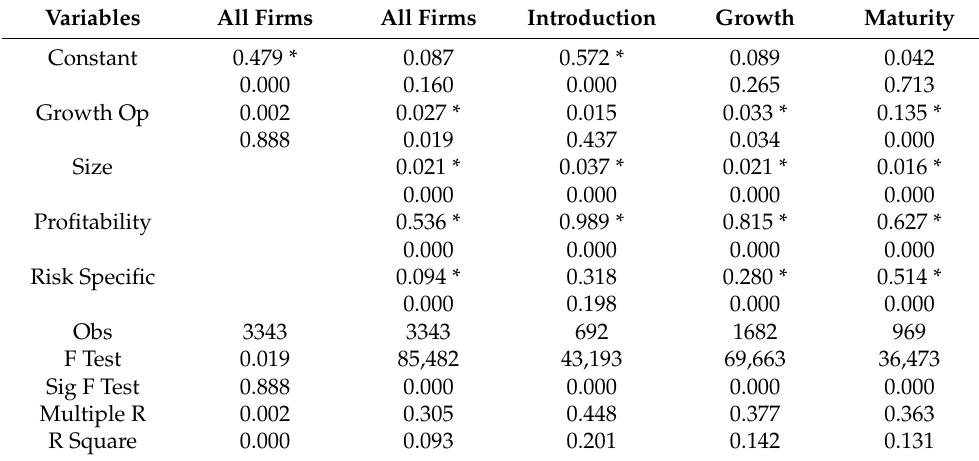
Table 4. Regression